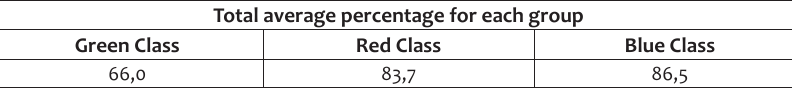
Table 4: Average performance for all